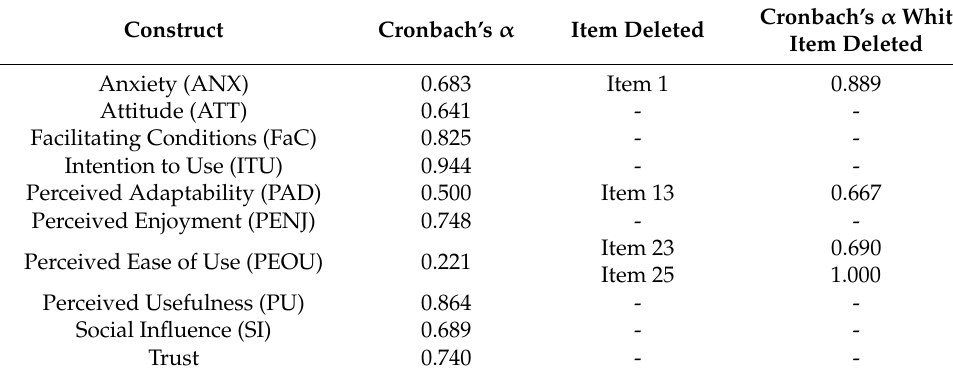
Table A4. Results of the Cronbach’s alpha analysis.